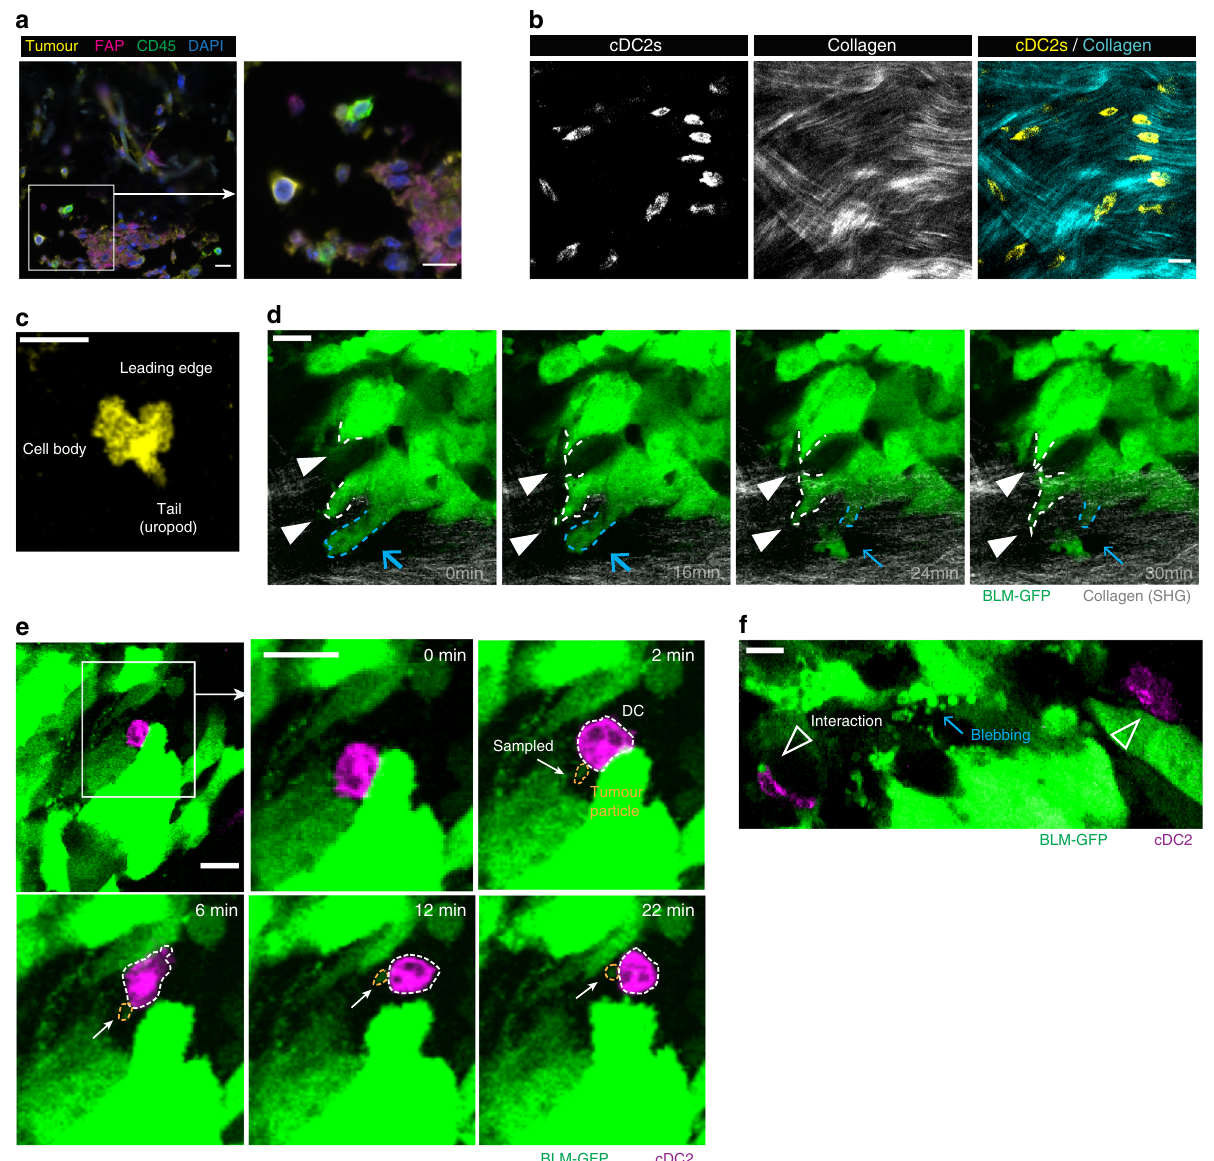
Fig. 3 Visualization of cDC2-tumour cell interaction. a Section of OMC showing multiplex fl uorescence immunohistochemistry representative area. cDC2s (CD45 + cells, green) are found in close proximity to melanoma cells (tumour (tyrosinase and SOX10) + cells, yellow) and fi broblasts (FAP + cells, magenta). DAPI (blue) indicates nuclei ( n = 2). b PKH26 (yellow) and second harmonic generation (SHG, cyan) signals of multiphoton images, acquired with excitation wavelength ( λ ) of 950 nm. PKH26 signal indicates cDC2s; SHG was generated by collagen bundles. c Characteristic amoeboid behaviour of DCs patrolling the environmental niche. d Representative time points during time-lapse recording of melanoma BLM cells expressing GFP [ λ (excitation) = 950 nm]. BLM cells showed high cellular dynamics (dotted lines; protrusion, white arrowhead and retraction, blue arrow). e , f Representative time points during time-lapse recording of cDC2s (PKH26)-tumour cell (GFP) interaction [ λ (excitation) = 950 nm]. e DC (dotted line, white) sensed and sampled tumour-derived particle (dotted line, yellow). f Prolonged interaction of DCs with tumour-derived fragments. Tumour cells showed intense membrane dynamics and blebbing. Scale bars, 20 μ